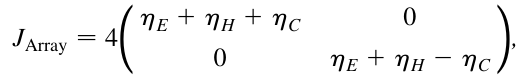
TABLE I. We describe the orientation of a semicircular scatterer in space using a vector p , pointing from the center of the semicircle to the midpoint on the wire segment, and a director d (nonoriented vector, i.e., d ¼ (cid:2) d ), which connects the segment’s endpoints.